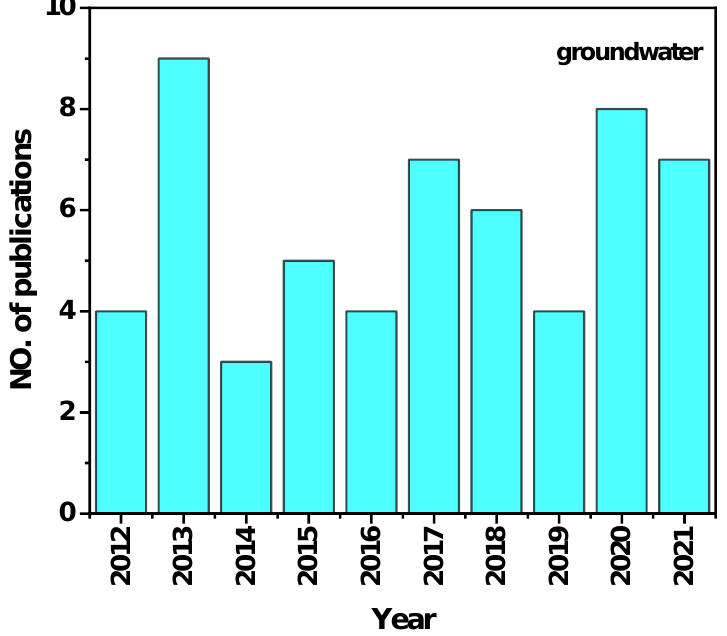
Figure 3. No. of publications on antibiotics in groundwater of China in previous ten years.